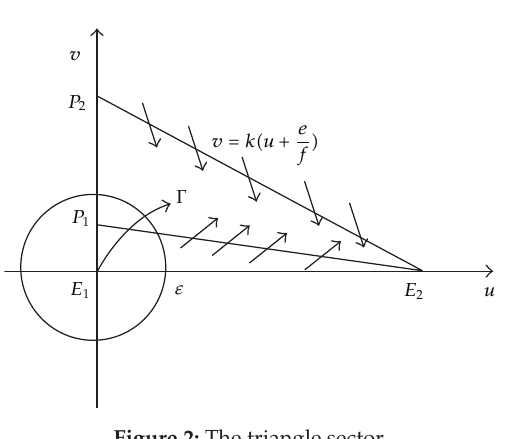
Figure 2: The triangle